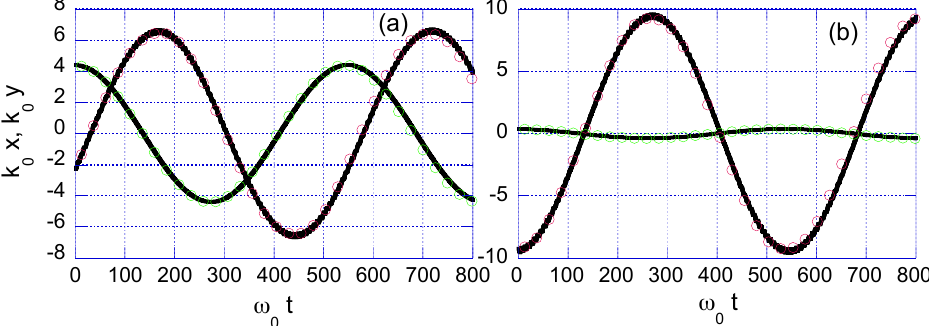
Figure 5. Temporal evolution of normalized x ( t ) and y ( t ) from full paraxial laser fields ( thick black lines) and from the approximate Hamiltonian, unfilled red ( x ( t ) ) and green ( y ( t ) ) circles. Two cases are displayed: ( a ) the initial conditions are x 0 = − 0.287747, y 0 = 0.5596 [ µ m], ( b ) the initial conditions are x 0 = − 0.287747, y 0 = 0.5596 [ µ m]. In both cases z 0 = 0 and E kin 0 = 0. Good quantitative agreement is found as regards the modulation frequency, amplitude and mutual phase of transverse